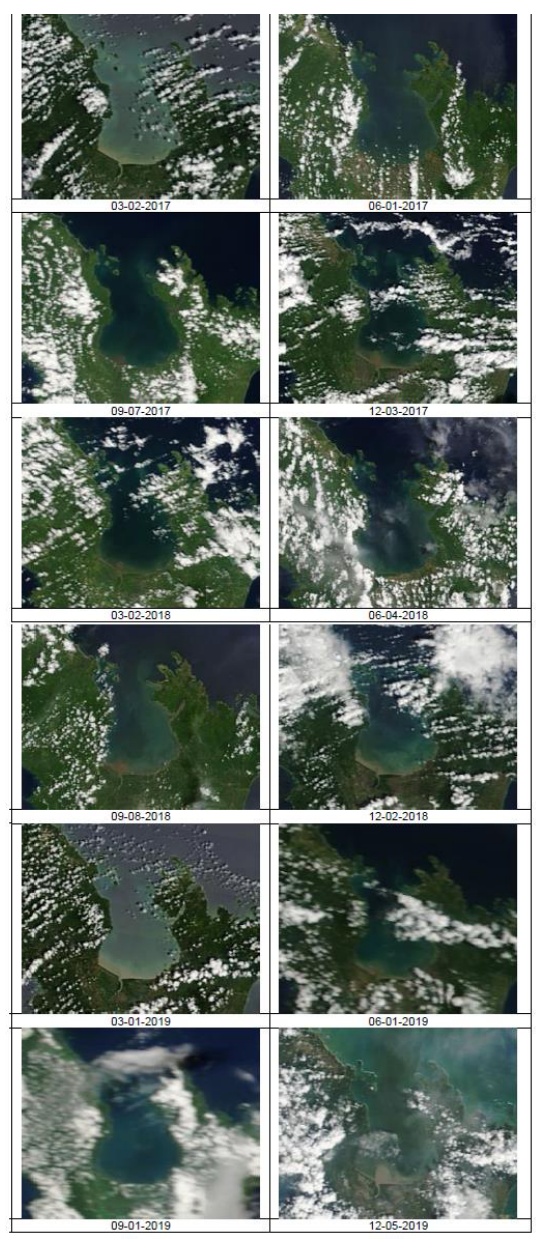
Figure 4 . Image Processing Phase 2 Figure 5 . San Miguel Bay Study Images